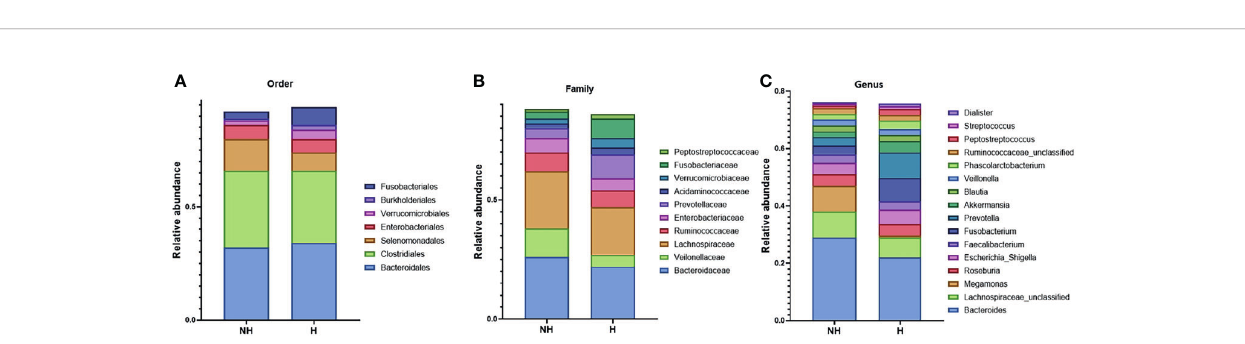
FIGURE 3 | The relative abundance of the bacterial taxa with more than 2% of the abundance. (A) The seven most abundant bacteria in the order level. (B) The 10 most abundant bacteria in the family level. (C) The 16 most abundant bacteria in the genus